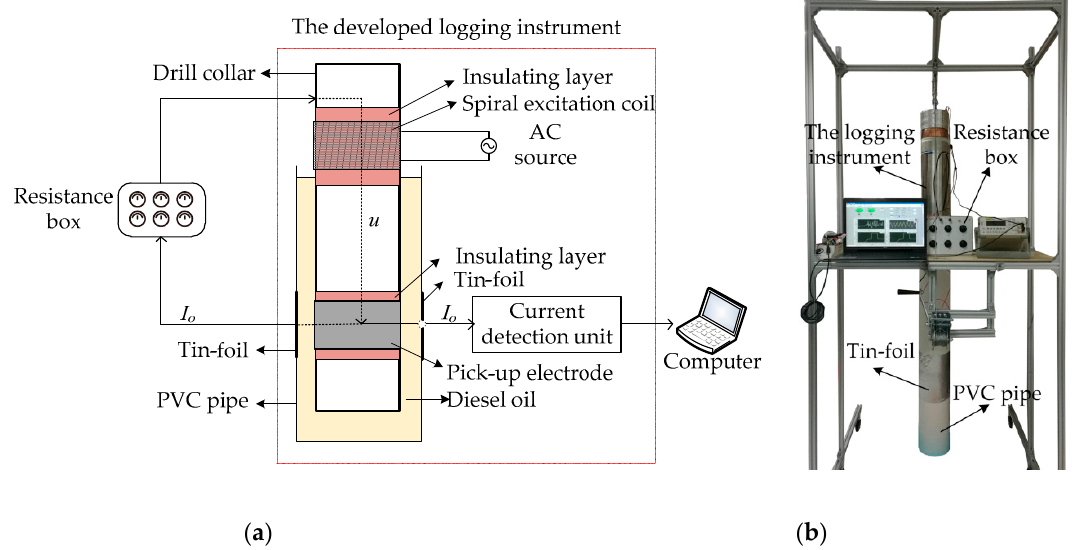
Figure 17. Experimental setup of resistance box experiment: ( a ) schematic; ( b ) photo.